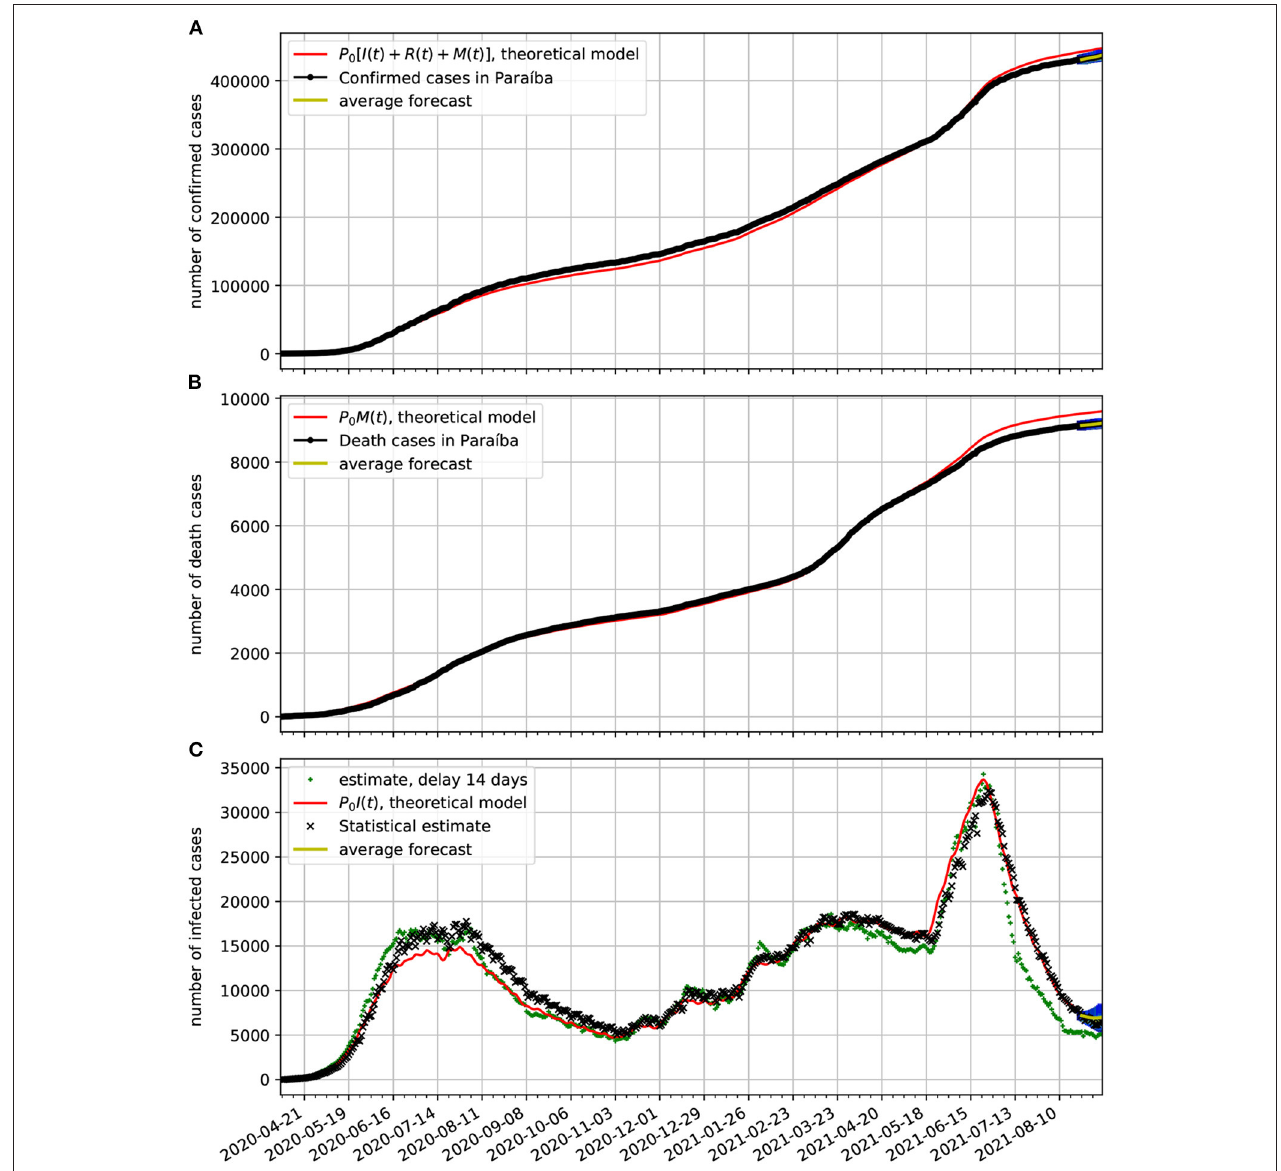
FIGURE 8 | Comparison of epidemiological data from Paraíba with the best fit based on our theoretical model. Also shown near the end of the time series are the statistical forecasting 95% confidence intervals, as described in Section 3.5. The theoretical fit is obtained with τ Comparison of the number of official confirmed cases with the theoretical prediction. (B) Comparison of the number of official deaths due to COVID-19 infection with the theoretical prediction. (C) Comparison of the number of the estimated number of active cases with the theoretical